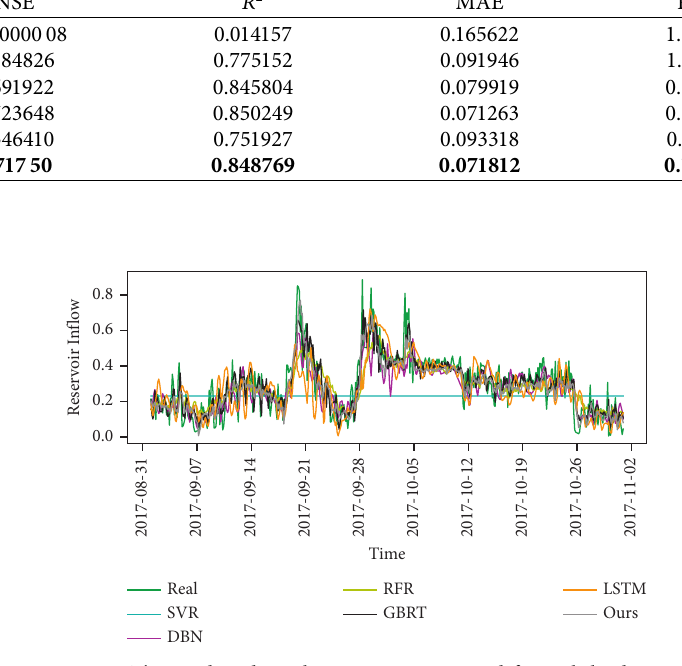
Figure 11: The predicted results over testing period for 12h lead times.